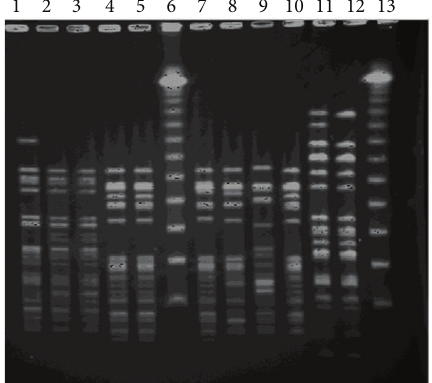
Figure 2: Sma 1 PFGE profiles of vancomycin-resistant E. faecium from major regional hospitals in Trinidad and Tobago, 2008– 2012. Lanes one to five and seven to 12 are representative of vancomycin-resistant E. faecium isolates from Trinidad and Tobago regional hospitals. Lambda ( 𝜆 ) DNA PFGE molecular size marker is indicated in marker lanes 6 and 13. Lane one = PFGE-1 or clone one; lanes two and three = PFGE-2 or clone two; lanes four, five, seven, eight, and ten = PFGE-3 or clone three; lane nine = PFGE-4 or clone four; lanes 11 and 12 = PFGE-5 or clone